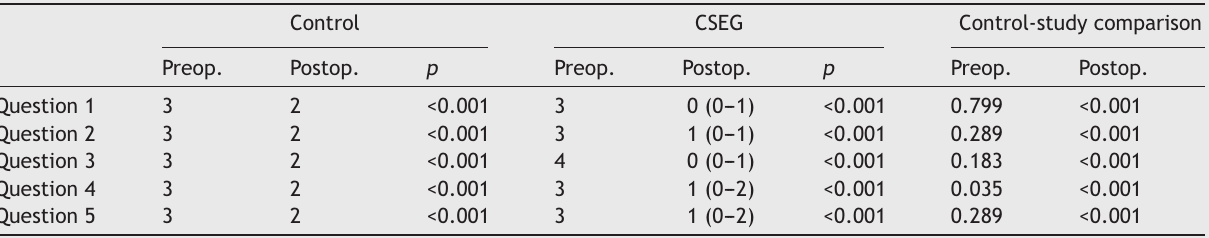
Nasal Obstruction Symptom Evaluation questionnaire results of the control and study group.